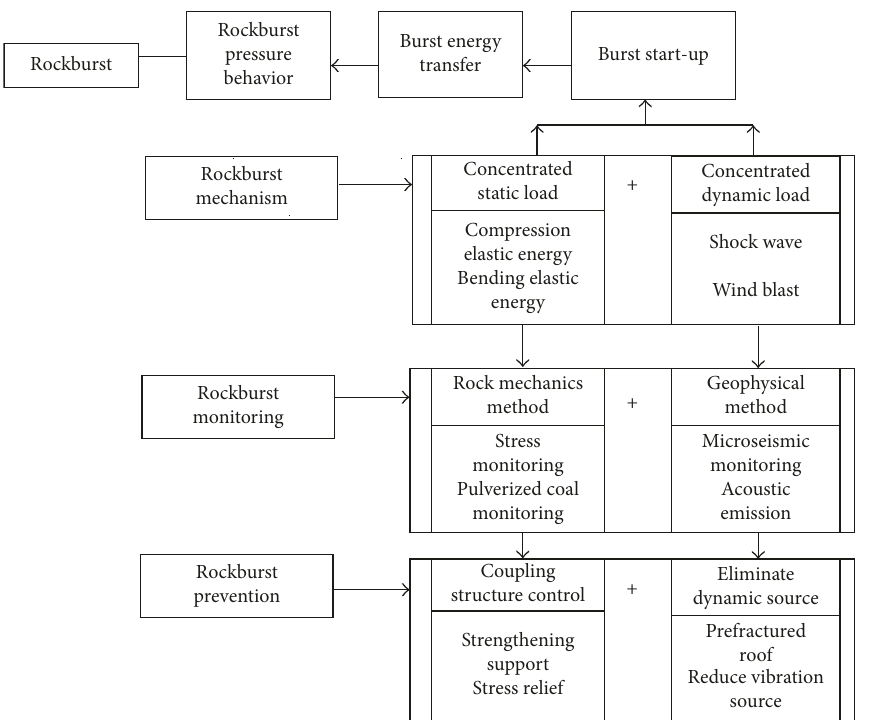
Figure 4: Theory and technical system of local rockburst